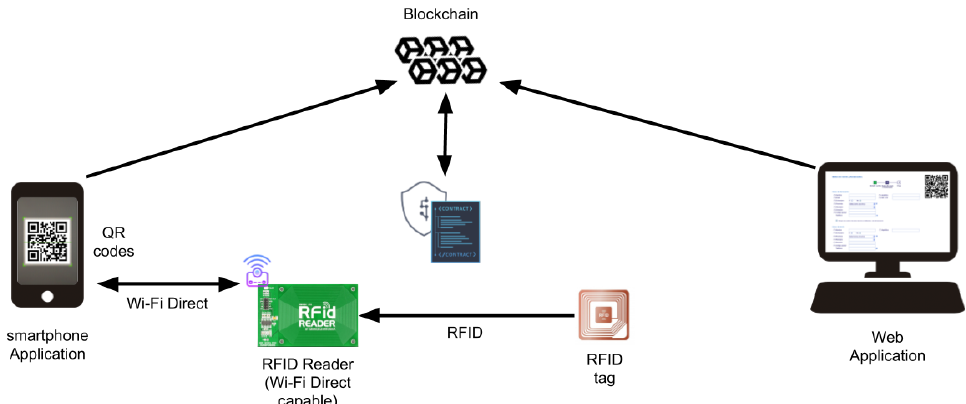
Figure 2. Relationship between technologies for the ubiquitous supply chain